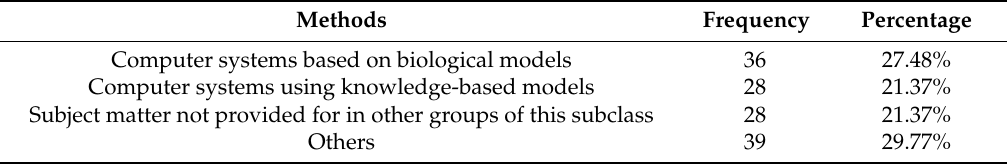
Table 3. Computational models classification results.